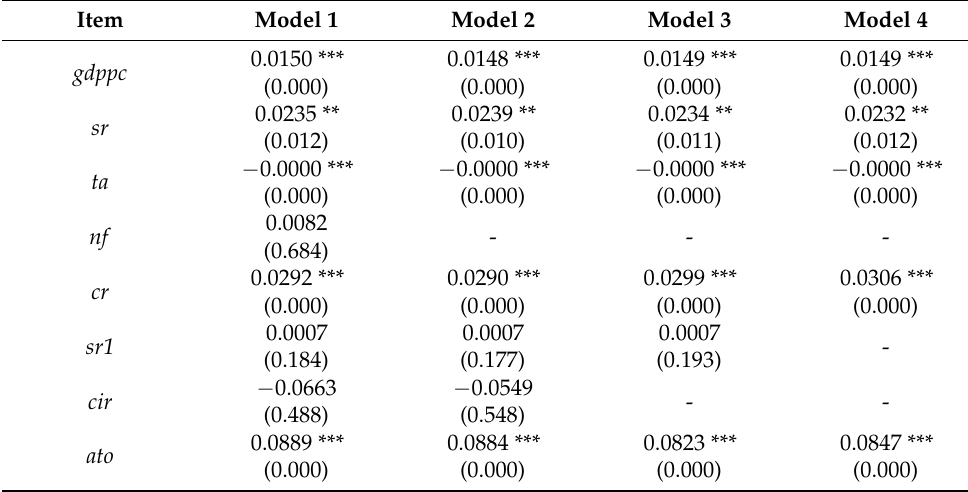
Table 8. Tobit model regression